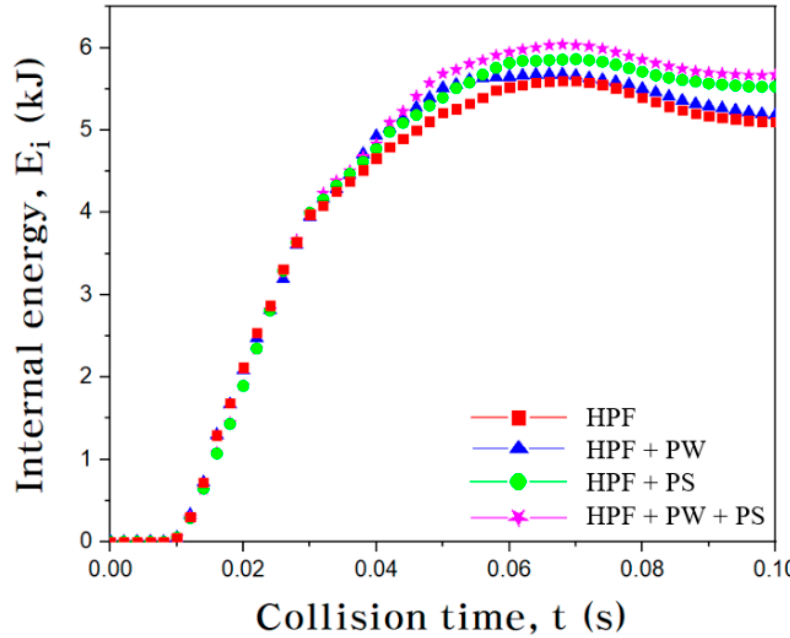
Figure 16. Internal energy ( E i ) of the four kinds of center pillar during a side crash.